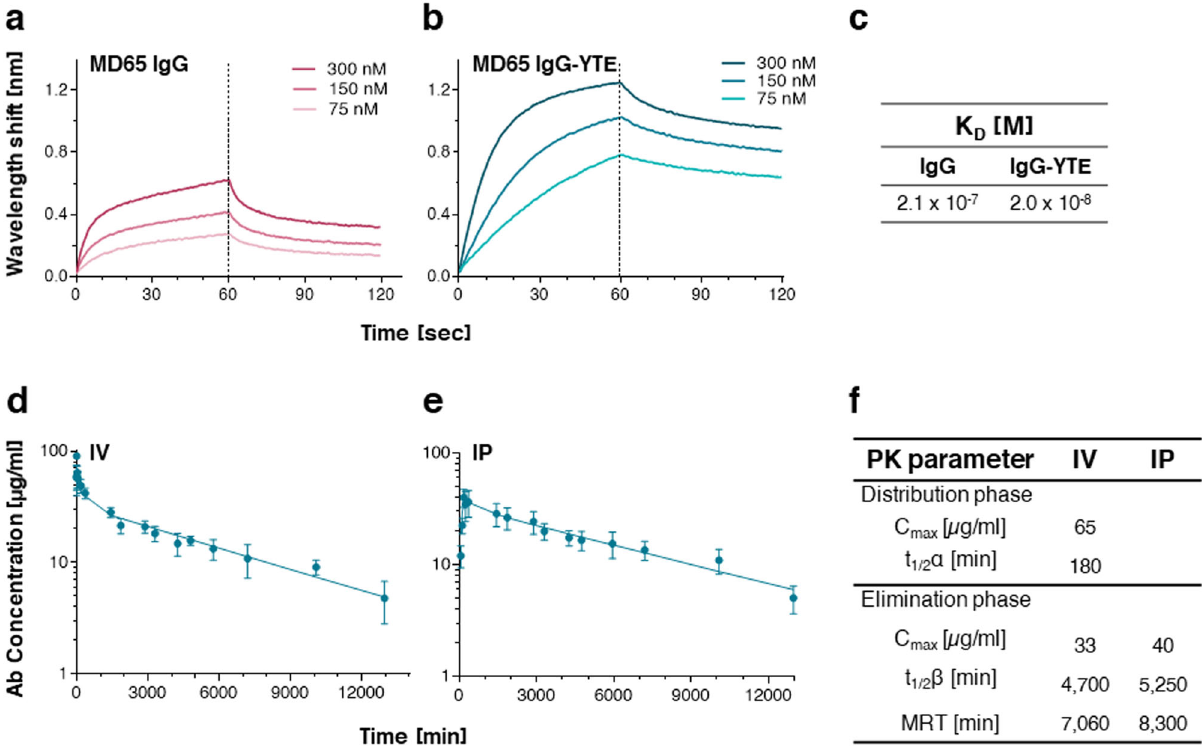
Fig. 2 MD65 binding to human FcRn and pharmacokinetic analysis. a , b Kinetics of the interactions between human FcRn and MD65 variants ( a IgG, curves in magenta nuances; b IgG-YTE, curves in turquoise nuances) at pH 6.0, using BLI. Immobilized antibodies were interacted with the indicated concentrations of human FcRn for 60 s (association phase) followed by a wash step (dissociation phase). c Steady-state analysis of sensorgrams by 1:1 binding model was used to determine equilibrium K D . d , e Plasma MD65 IgG-YTE concentrations in C57BL/6 mice were determined at the indicated time points following a single d IV ( n = 4) or e IP ( n = 5) administration of 0.2 mg Ab. Values are expressed as mean ± SEM that were fi tted using non- compartmental analysis. f Pharmacokinetic parameters of MD65